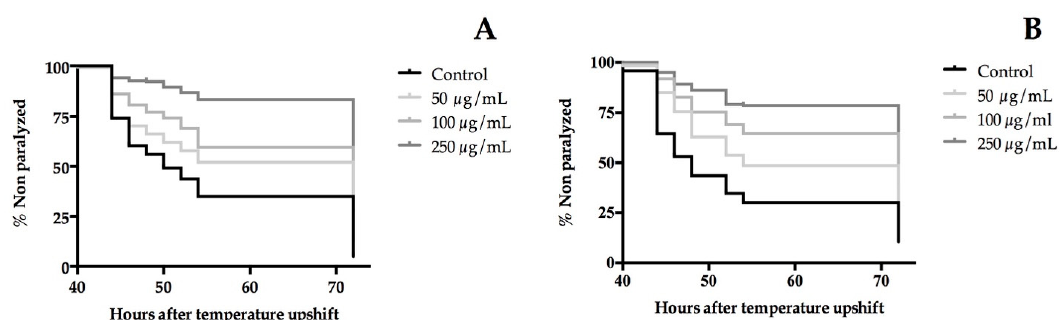
Figure 4. Effect of ( A ) orange cultivar and ( B ) yellow cultivar of T. erecta flower extracts on A β -induced paralysis on transgenic C. elegans CL4176. The PT 50 for orange cultivar were 50 hours for the control group and 72 hours for all treated groups and for yellow cultivar were 48 hours (control group), 54 hours (50 µ g/mL treated group), 72 hours (100 µ g/mL treated group), and the PT 50 was not achieved in the group treated with 250 µ g/mL. Statistical significance of the difference between the experiments was analyzed by a log-rank (Kaplan-Meier) statistical test, which compares the survival distributions between the control and treated groups. Differences in survival tests between treatment and the control group were found in: ( A ) 50, 100, and 250 µ g/mL, p < 0.0001, ( B ) 50, 100, and 250 µ g/mL, p < 0.0001.